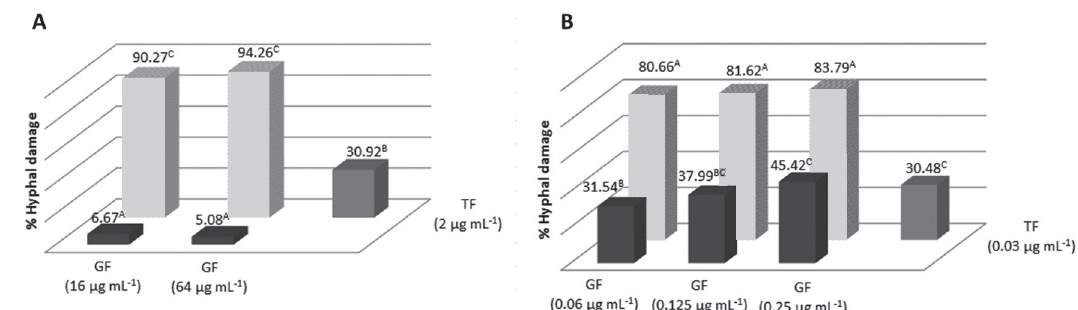
FIGURE 1 - Hyphal damage expressed in percentage of the griseofulvin (GF) (  ) and terbinafine (TF) (  ) alone and in combination (  ). A) Hyphal damage of the TME 16 drug resistant isolate to the combination of TF and GF antifungals at concentrations below MIC; B) Hyphal damage of TME 32 drug sensitive isolate to combination of TF and GF antifungals at concentrations below MIC. Different letters above the hyphal damage represent a statistically significant difference (p